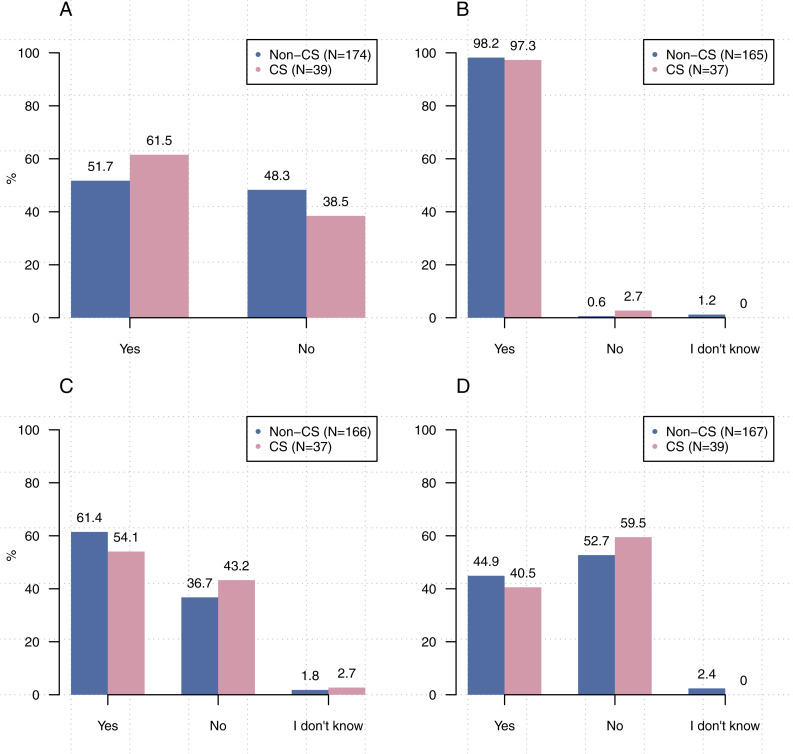
Reproducibility practices in research.(A) Have you received training in coding conventions or best practices? (B) Do you include comments in your code? (C) Do you generate documentation for your code? (D) Do you write code using a notebook?